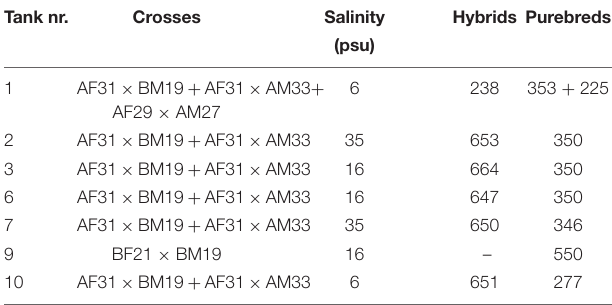
TABLE 1 | Overview of parents used for producing the F1 progeny. Tank